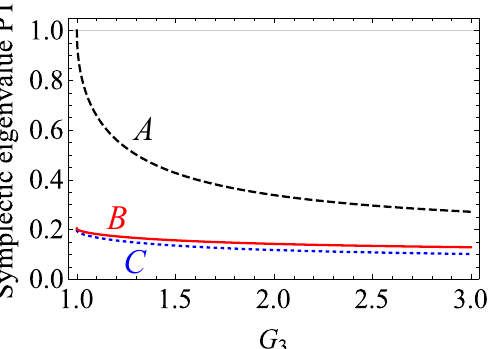
Figure 3. The dependence of smallest symplectic eigenvalues E ˆ E ˆ ( C ) on power gain G 3 under the conditions of G 1 = G 2 = 2, η = 1, β = A 2 − ˆ C 1 ˆ A 3